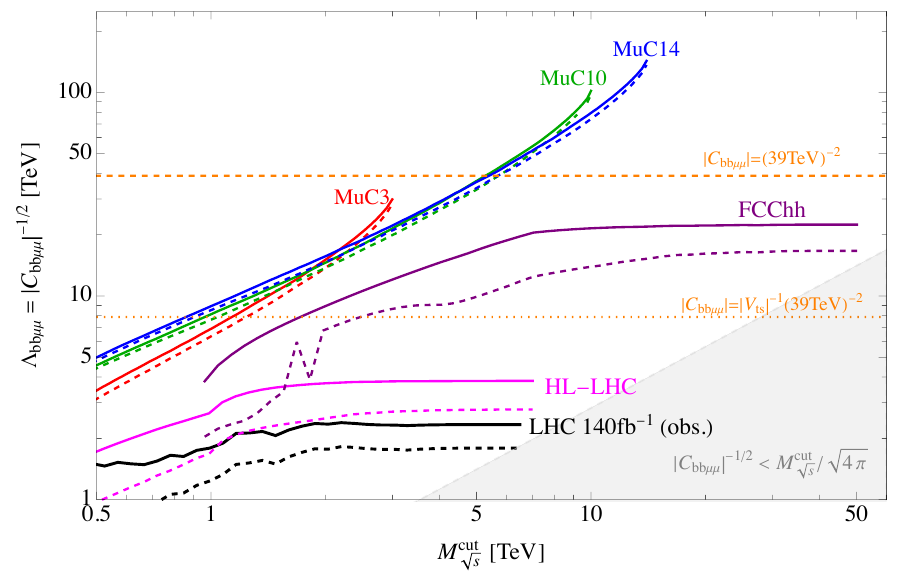
Figure 8 . Sensitivity reach (95%CL) for the (¯ b L γ α b L )(¯ µ L γ α µ L ) contact interaction as function of the upper cut on the final-state invariant mass. Solid (dashed) lines represent the limit for positive (negative) values of C bbµµ . The orange dotted and dashed lines shows reference values in relation to the bsµµ anomalies fit, with or without a 1 /V ts enhancement of the bb operator compared to the bs one,